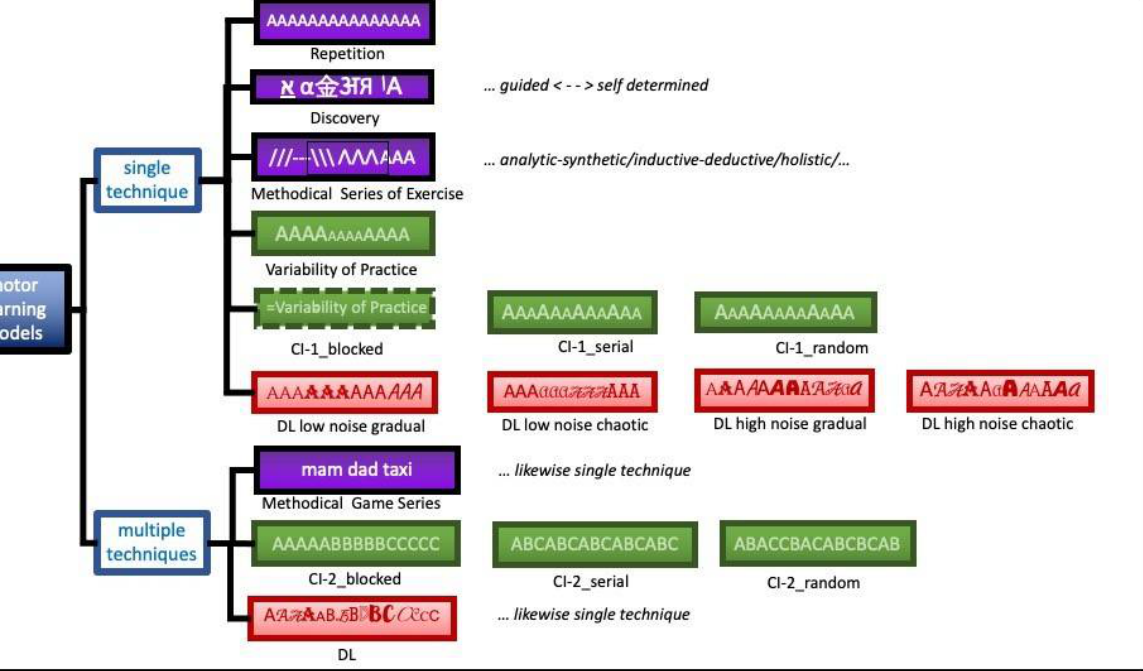
Figure 1. schematic visualization of the motor learning models discussed. A, B, and C correspond to different movement techniques. The three colors correspond to the origin of the models. Purple: pedagogical origin; green: sport psychological origin; red: system dynamic origin. CI: Contextual Interference Learning; DL: Differential Learning.